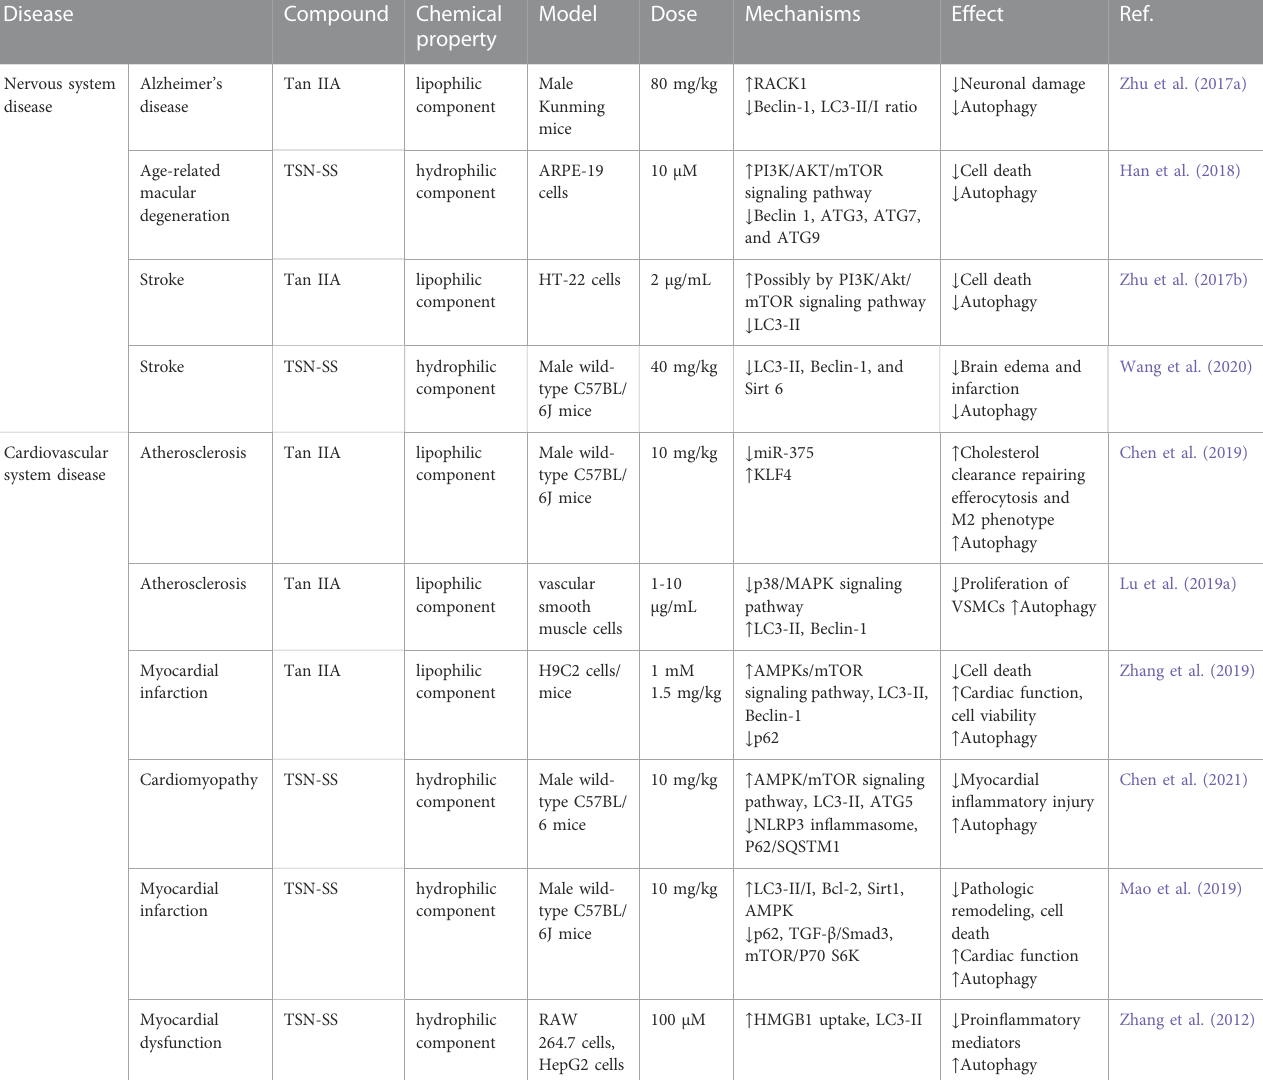
TABLE 2 Detailed information on tanshinone in regulating autophagy in the nervous system and cardiovascular diseases. Disease Compound Chemical